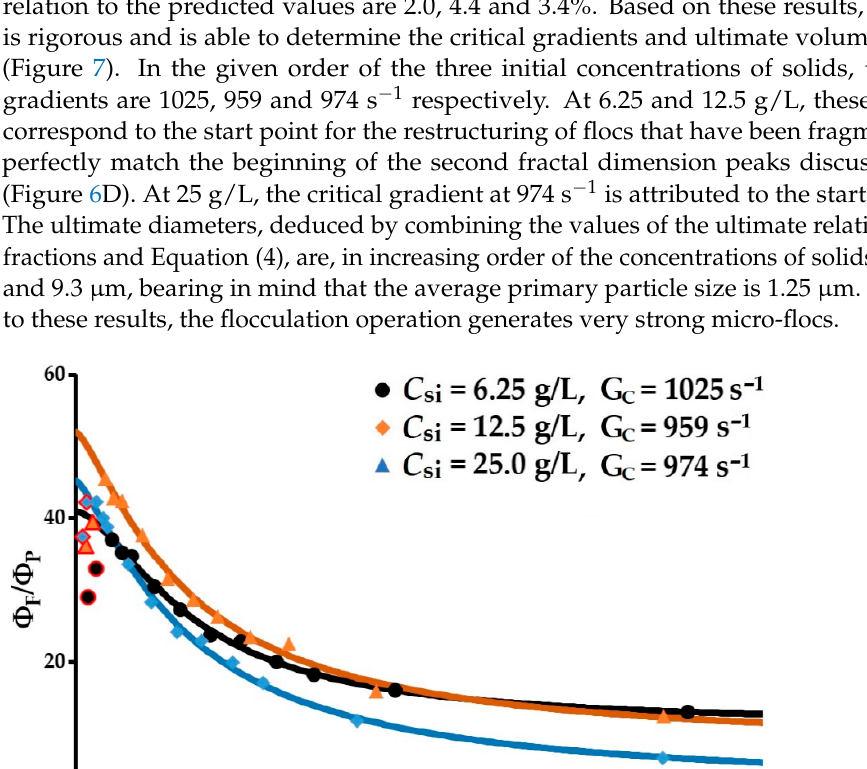
Table 2. Parameters from the proposed model (Equation (29)) for the relationship between floc size and velocity gradient.